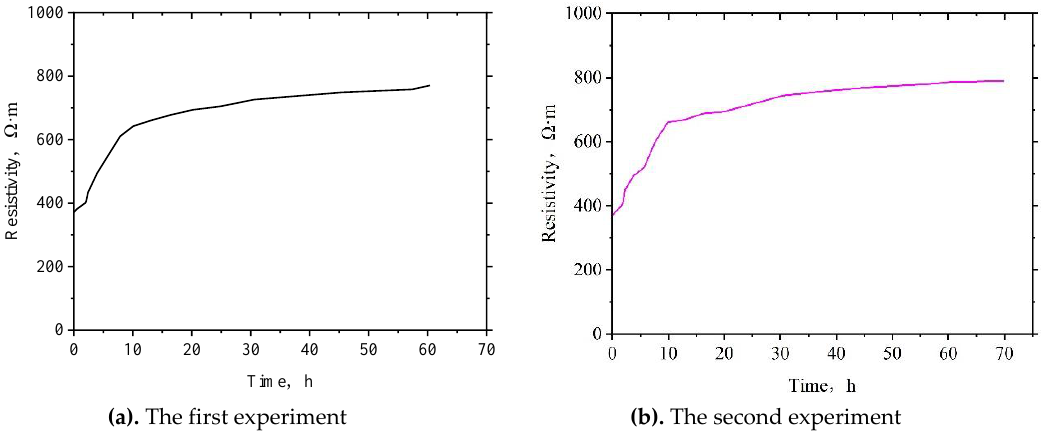
Figure 12. Resistivity changes during preparation of hydrate by bubbling method .